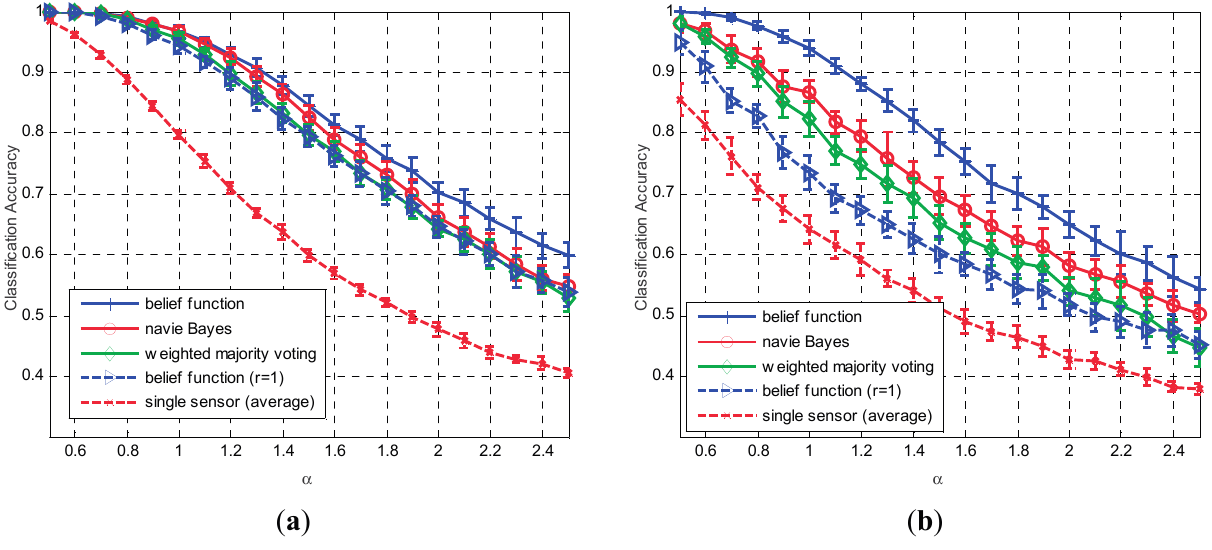
Figure 4. Average classification accuracy (plus and minus one standard deviation) as a function of α values, obtained by 20 repetitions. The sensor number is fixed as M = 5